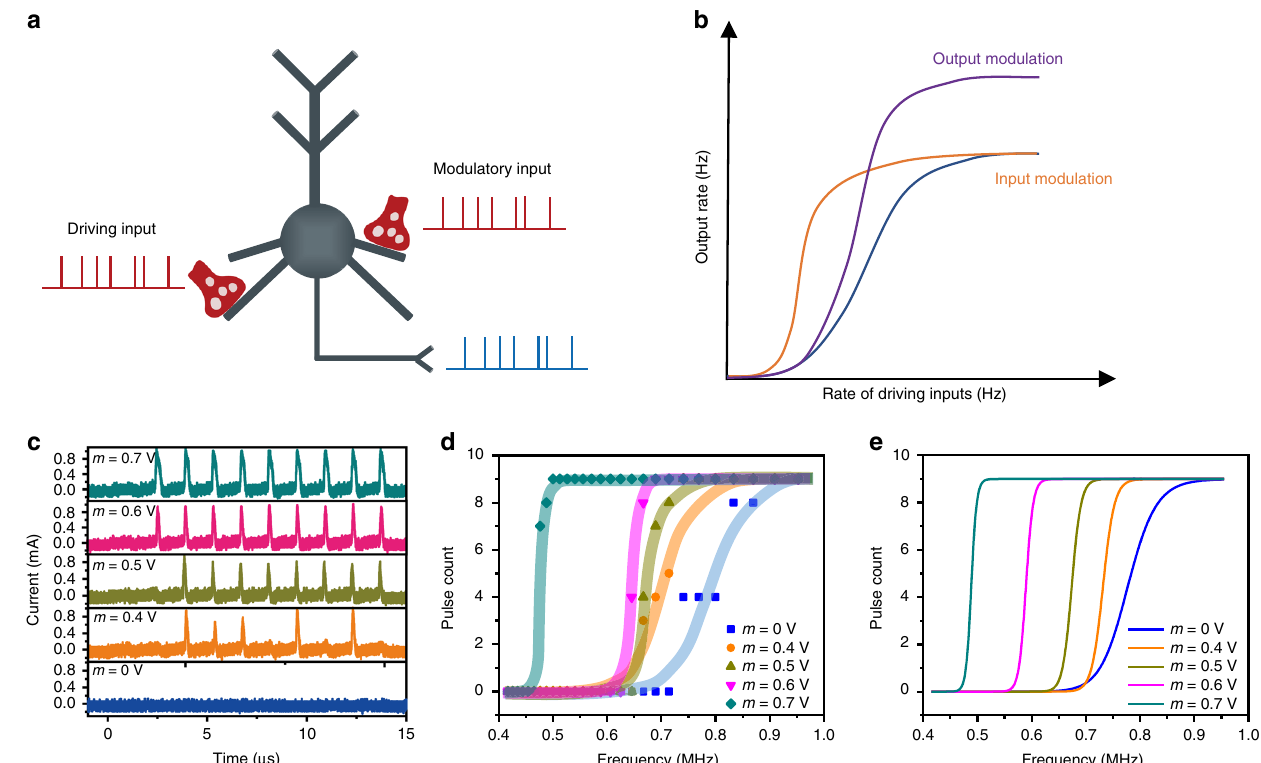
Fig. 4 Neuronal gain modulation of NbO x based neuron. a Schematic diagram of the rate-coded neuronal signaling. The driving input and modulatory input affect output fi ring rate jointly. b Schematic diagram of neuronal gain modulation by modulatory inputs, including input modulation (orange line) and output modulation (purple line). The blue line is the I – O curve with only the driving input. c Neuronal responses triggered by only the driving input (1.2 V amplitude, 1 μ s width, 0.4 μ s interval) applied on S 1 (bottom), and triggered by the driving input (1.2 V amplitude) and modulatory input (1 μ s width, 0.4 μ s interval) with different amplitudes of 0.4 V, 0.5 V, 0.6 V and 0.7 V, applied simultaneously to nodes S 1 and S 2 , as shown in the middle and top of the panel. d Experimental neuron responses showing multiplicative gain modulation when applying different modulatory inputs ( m = 0, 0.4, 0.5, 0.6 and 0.7 V). The background lines indicate the overall trend in data. e Fitting lines calculated by Eq.